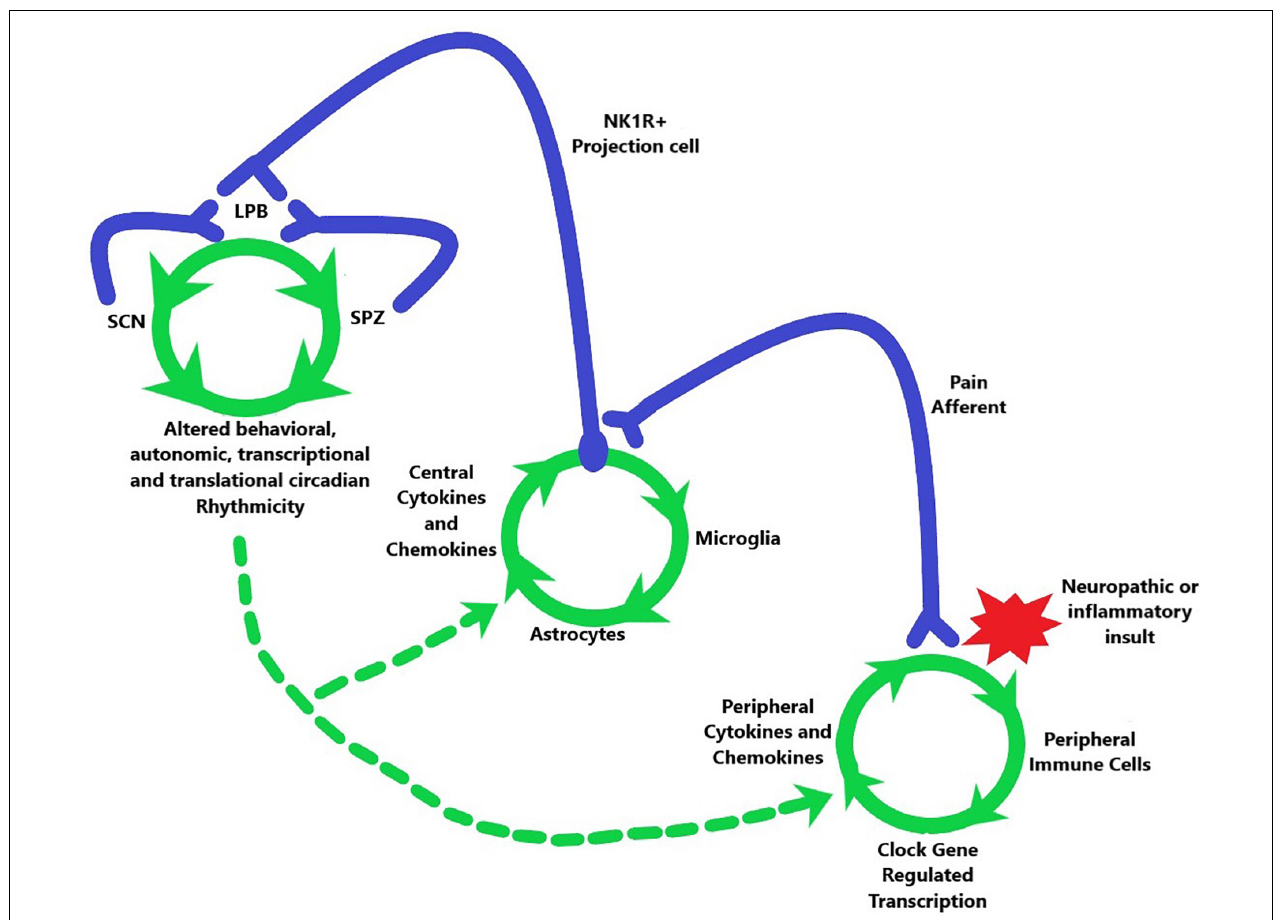
FIGURE 3 | Potential model for the travel of the pain induced positive feedback system, initiated by a neuropathic or inflammatory insult (red star), from the periphery (lower right green circle) to the spinal cord (middle green circle) and then to the brain (upper left green circle). Green arrows indicate order of activation or alteration in each system. This travel leads to altered circadian output of multiple physiological systems (where green arrows converge at bottom of top left green circle). The circadian system is also able to affect the pathway through axonal connections back from the SPZ and SCN to the LPB as well as by modulating the spinal and peripheral phenomena in chronic pain. This modulation has differing effects depending on the circadian time which is indicated by dashed green